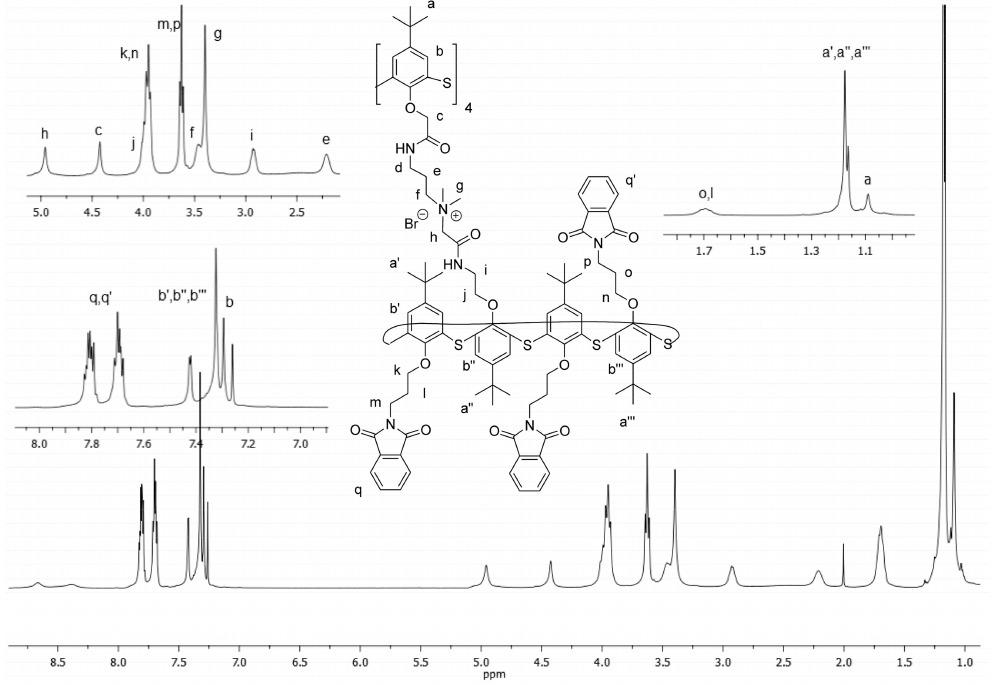
Figure 2. 1 H NMR spectrum of multithiacalix[4]arene 6